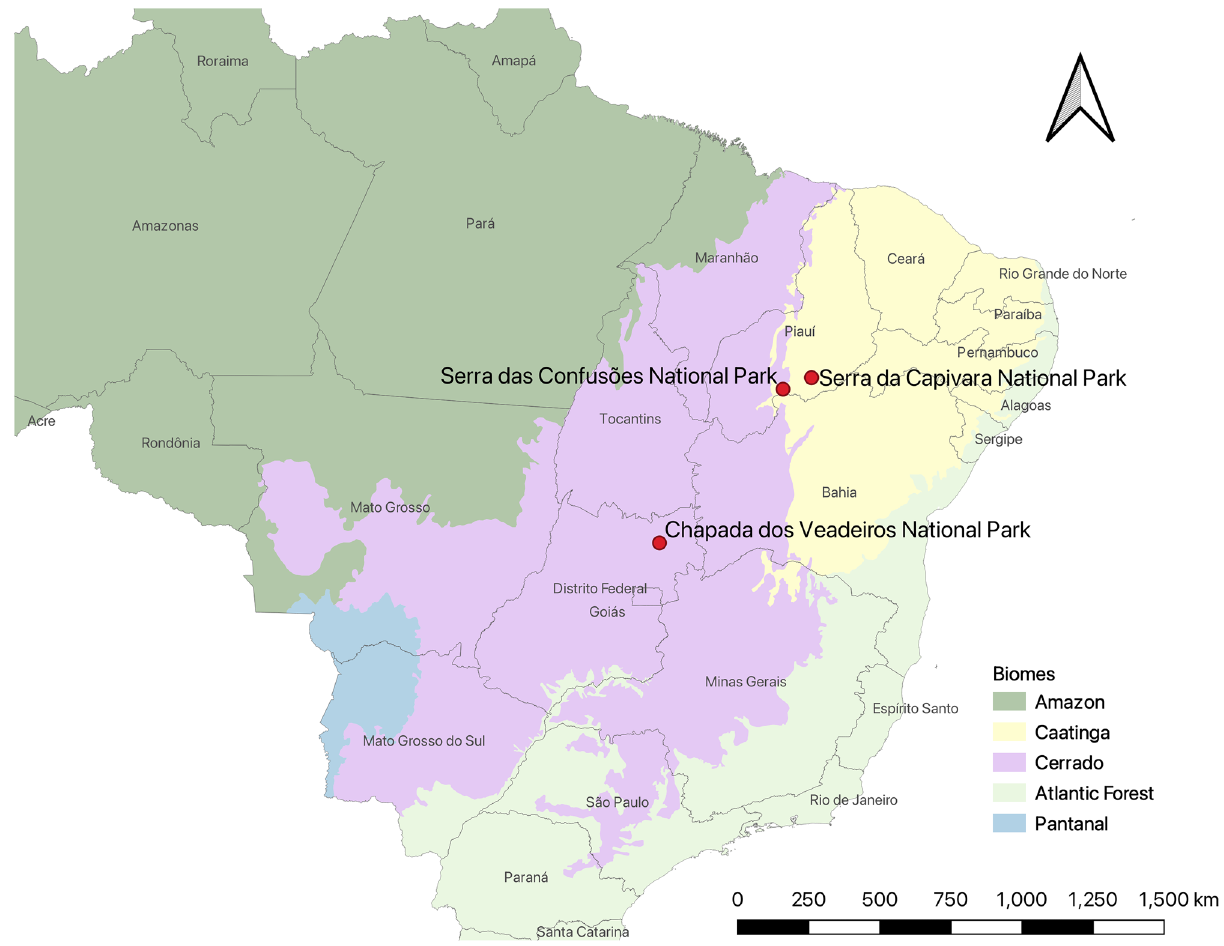
Figure 1. Map of Brazil with the locations of the study sites on this work (red dots). Biomes are indicated by color (see legend). Map created by Tiago Falótico, using QGIS 3.16 (https:// www. qgis. org) and biomes data from